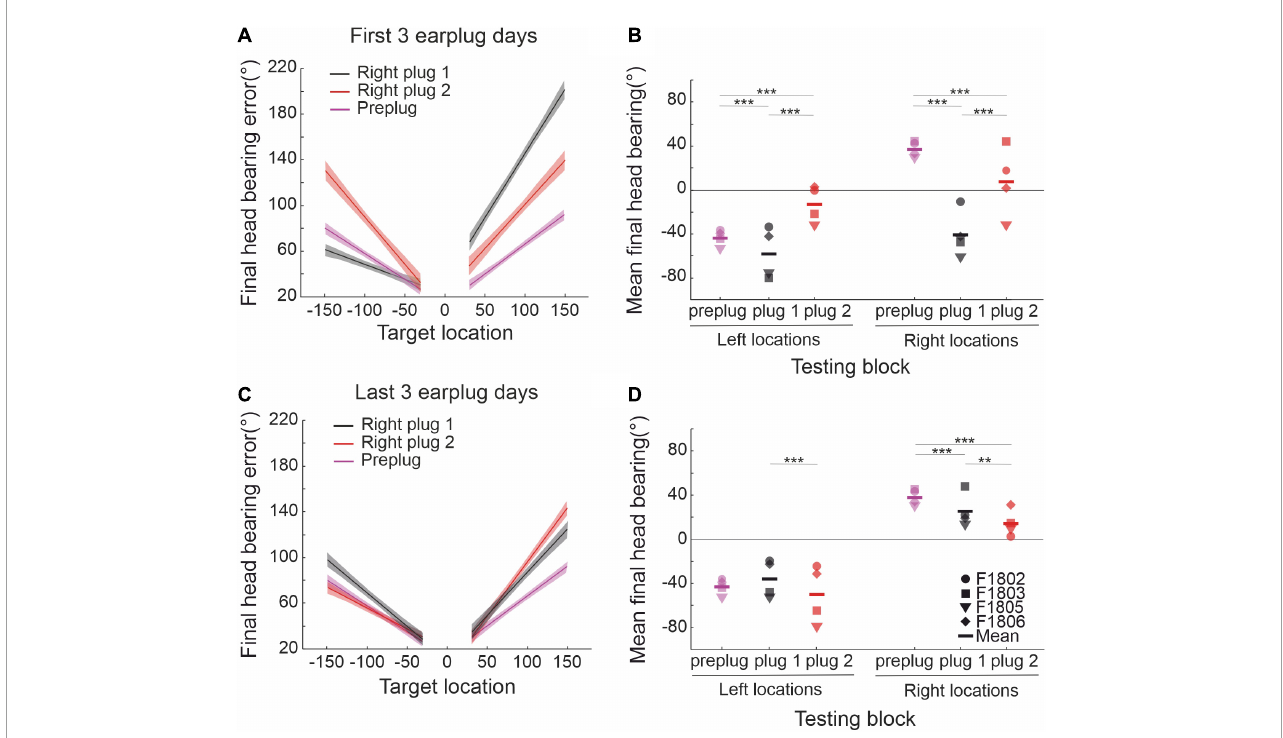
FIGURE5 Persistence of adaptation in the sound-evoked head orienting responses. (A) Linear regression fits and their 95% confidence intervals for the mean final head bearing errors in the first 3 days of the right plug 1 and 2 runs (black and red lines, respectively). For comparison linear fits for preplug responses are shown in magenta. (B) Mean final head bearing shown separately for left and right target positions in the first 3 days of the right plug 1 and 2 runs. Midline locations (0 ◦ and 180 ◦ ) were excluded. Note that the head orienting responses were no longer as biased toward the side of the open left ear at the start of the second period of right ear occlusion. (C) Linear regression fits and their 95% confidence intervals for the mean final head bearing errors in the pre-plug responses (magenta lines) and in the last 3 days of the right plug 1 and 2 runs (black and red lines, respectively). (D) Mean final head bearing shown separately for left and right target positions in the last 3 days of the right plug 1 and 2 runs. (** p < 0.01, *** p < 0.001).